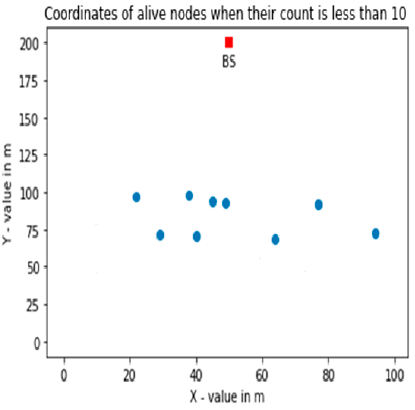
Figure 17. Placement of alive nodes when the count is less than 10 with uniform distribution of high energy nodes.